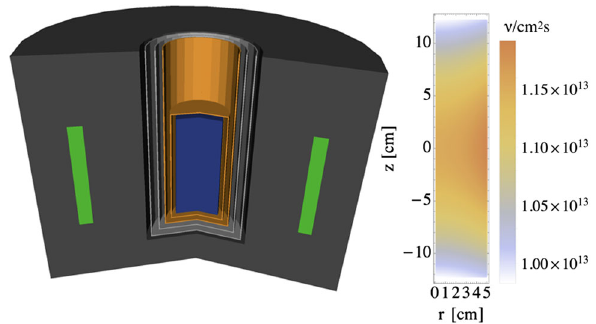
Fig. 3 Left: cylindrical detector of 2000 cm 3 with 5 cm radius (blue), placed inside a cylindrical cryostat 5 cm thick (orange - light gray). The 10000 cm 3 source (green) is deployed in a toroid around the cryostat and shielded in the radial direction by 12 cm of tungsten (dark gray). The source is at an average distance of 25 cm from the detector center, and its height (25 cm) is chosen to maximize the neutrino flux. Right: simulation of the neutrino flux at the detector in cylindrical coordinates fora 51 Crsourcewithinitialactivityof5MCiaveragedover2half-lives (55.4 days)